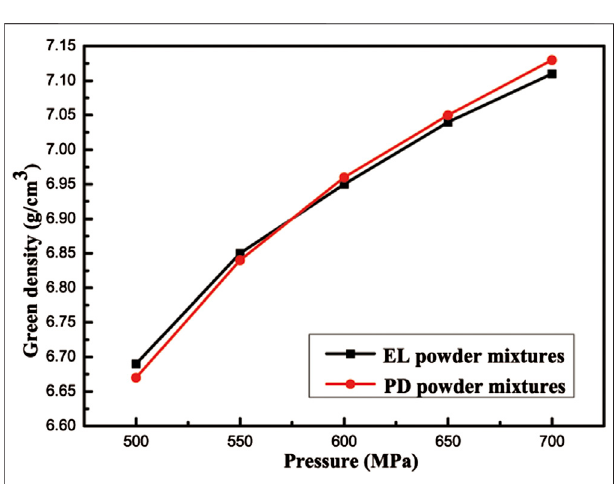
FIGURE 2 | Green density of the Fe-2Cu-0.8C-0.6Mo-2W compacts as a function of compaction pressure of 500 – 700